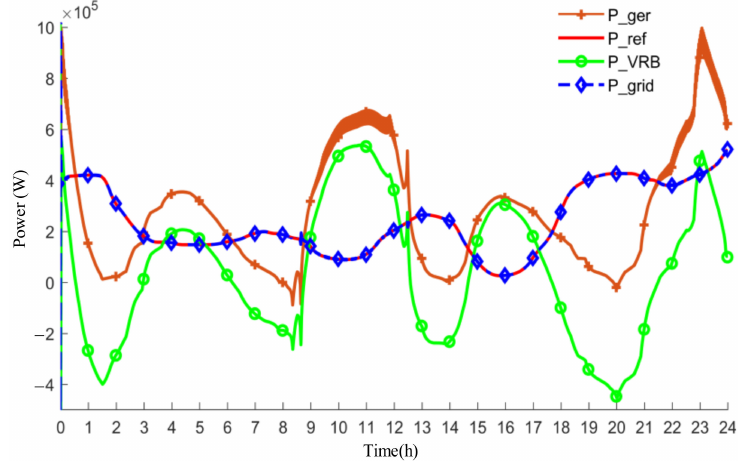
Figure 13. Power flow of marine current power system over 24 h based on conventional control strat- egy.